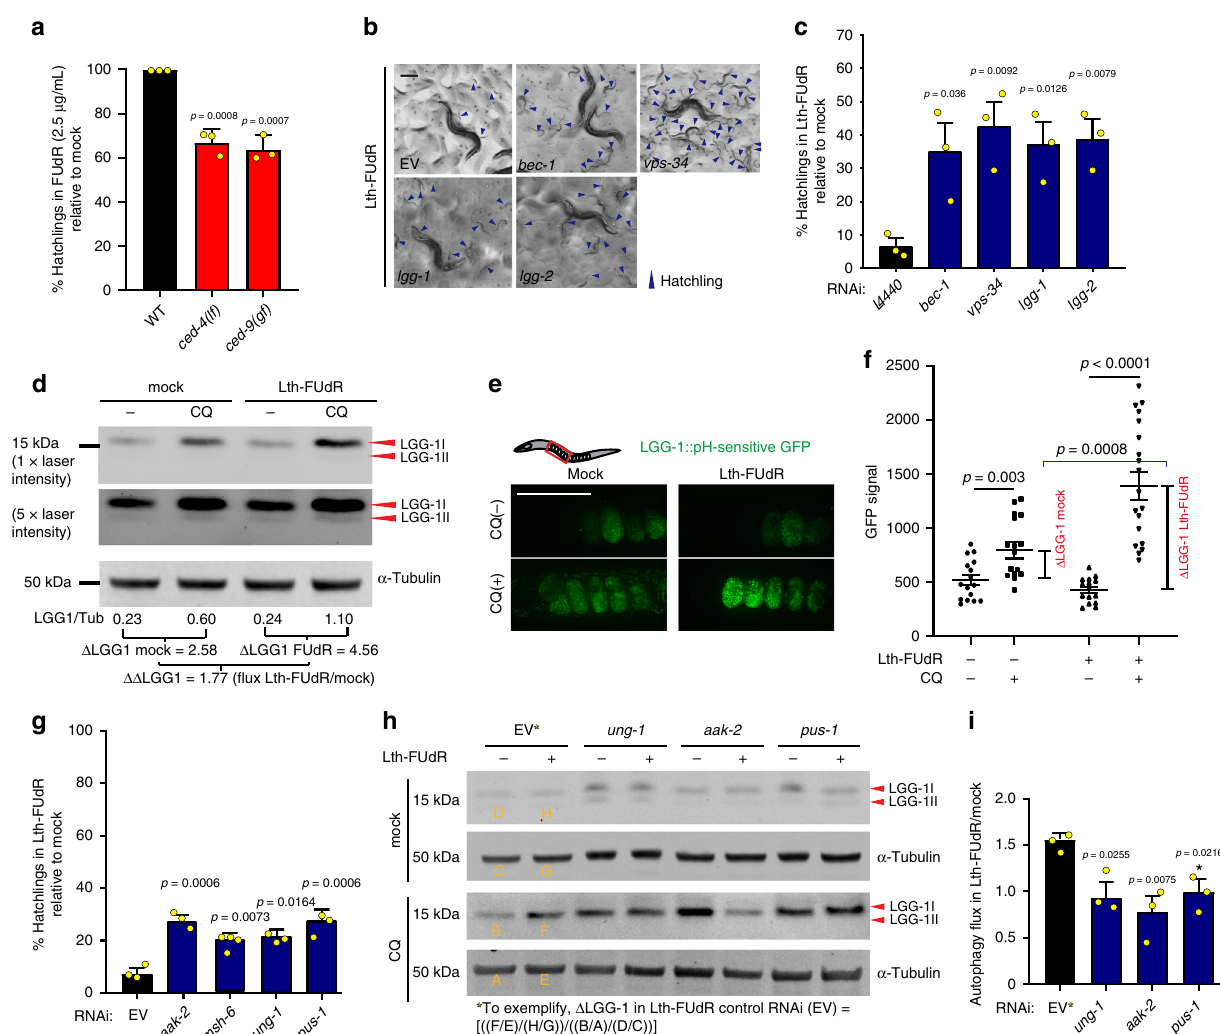
Fig. 5 Lth-FUdR activates autophagic cell death in C. elegans . Throughout this fi gure: % hatchlings was analyzed as described in Fig. 1. Statistical signi fi cance was assessed via two-tailed unpaired nonparametric t -test for % hatchlings quanti fi cation. Statistical signi fi cance for western blotting ratio was assessed via one-tailed ratio t -test. Data are presented as mean values ± SEM, n = # independent biological replicates. Source data are provided as a Source Data fi le. a Quanti fi cation of progeny viability of WT, ced-4(n1162) , and ced-9(n1950) mutant C. elegans exposed to 2.5 μ g/mL FUdR (lower dose of FUdR used to enable detection of enhancers). n = 3. b Representative images of progeny viability of C. elegans exposed to Lth-FUdR while cultured on EORB1 EV or autophagy RNAi clones. Scale bar = 200 µ m. c % hatchling quanti fi cation of treatments represented in b . n = 3. d Representative α LGG-1 western blotting of worms cultured on EORB1 lawn ±Lth-FUdR (7.5 μ g/mL) ±8 h exposure to 20 mM chloroquine (lysosomal inhibitor). Two different exposures of α LGG-1 blot are depicted. Autophagy fl ux estimation and data interpretation described in main text and Methods. n = 10. e In vivo imaging of embryos expressing LGG-1::GFP(pH-sensitive) treated with ±Lth-FUdR (7.5 μ g/mL) and ±8 h of 20 mM chloroquine. Scale bar = 100 μ m. f Quanti fi cation of GFP signal of treatments represented in e , two-tailed, unpaired, nonparametric t -test. LGG-1::GFP data acquisition, analyses, and interpretation described in main text and Methods. Unpaired nonparametric one-tailed t -test was used to singly compare average GFP signal in ( + )CQ to ( − )CQ (denoted with black brackets and asterisks), and one-tailed ratio t -test was used to compare Δ LGG-1 ratios (denoted with blue brackets and asterisks). n = 3. g Quanti fi cation of progeny viability of C. elegans exposed to Lth-FUdR (7.5 μ g/mL) while cultured on EORB1 EV or RNAi against aak-2 , msh-6 , ung-1 , or pus- 1 . n = 3. h Representative α LGG-1 western blotting of worms cultured on EORB1 EV or RNAi against ung-1 , aak-2 or pus-1 ± Lth-FUdR (7.5 μ g/mL) ±8 h of 20 mM chloroquine. Approach, data analyses, and interpretation described in main text and Methods. i Autophagy fl ux quanti fi cation as depicted in h , and described in Methods. n =